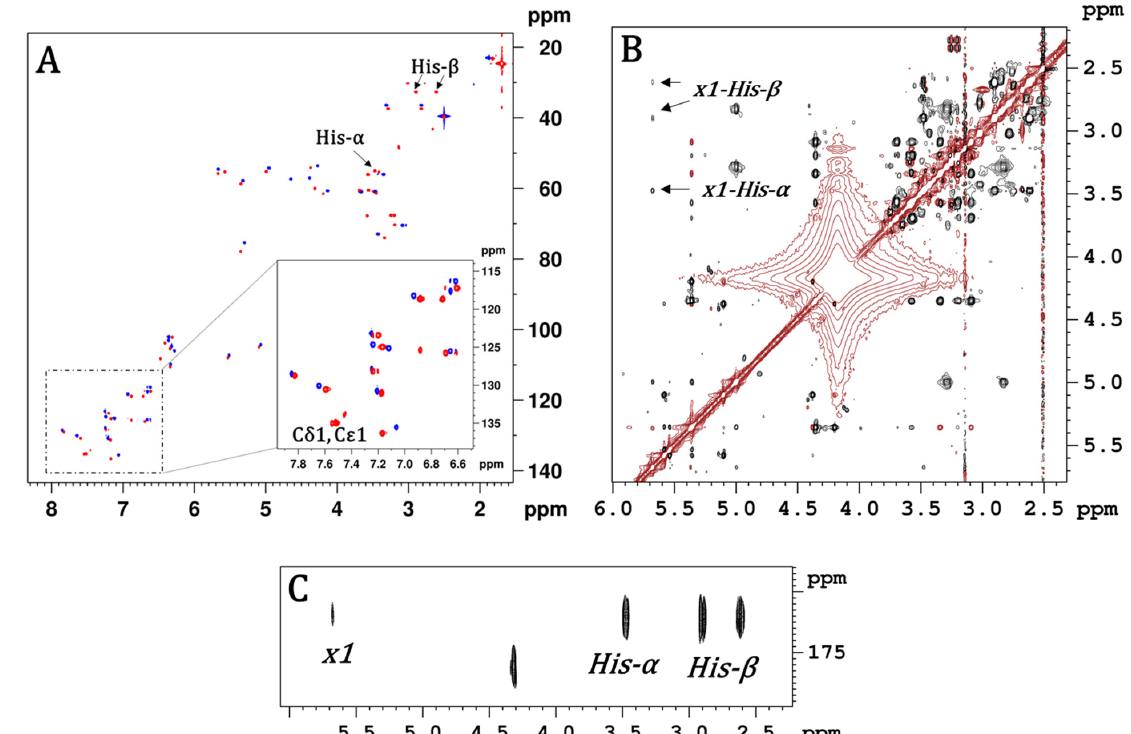
Figure 2. Excerpts of 2D homo- and heteronuclear correlation maps. ( A ) Overlay of the 13 C- 1 H HSQC spectra of teicoplanin pseudoaglycone 3 (blue) and its histidyl conjugate 20 (red). Additional resonances arise from the histidyl group atoms (aromatic C δ 1, C ε 1 and H α , H β correlations are labeled). ( B ): Selected 1 H- 1 H ROESY spectral region indicates the spatial proximity (<0.5 nm) of histidyl H α and H β atoms to the H α of the first residue (x1). ( C ): 13 C- 1 H HMBC excerpt demonstrates correlation between the carbonyl atom and x1 proton as proof of connectivity between the glycopeptide chain and the histidyl group. Intraresidual correlations of histidyl carbonyl with H α and H β are also labeled. The resonance assignments for the identified atoms are as follows: 54.74 ppm (C α ), 32.38 ppm (C β ), 135.15 ppm (135.00 ppm (C δ 1), 135.08 ppm (C ε 1), 174.41 ppm (CO), 3.47 ppm (H α ), 2.89 ppm (H β 1), 2.61 ppm (H β 2), 7.55 ppm (H δ 1), and 7.52 ppm (H ε 1).